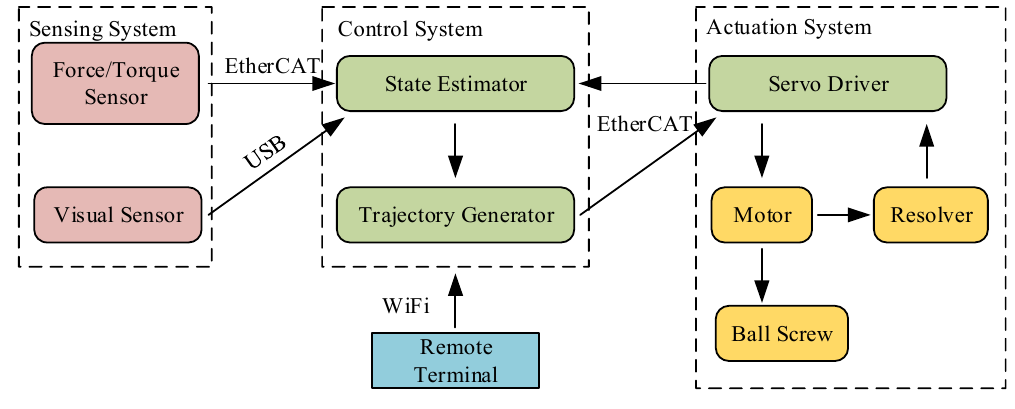
Figure 2. System structure of the robot.